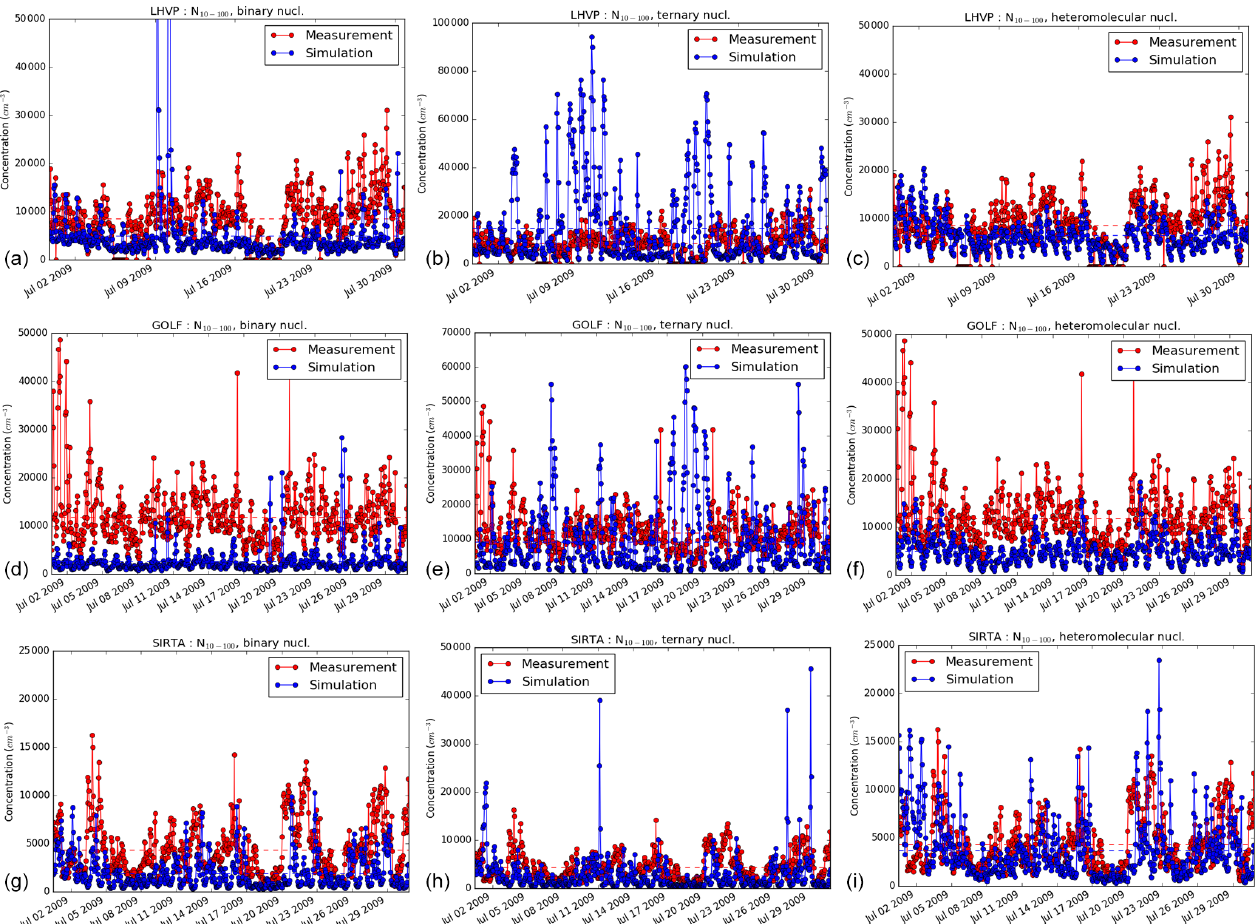
Figure 10. Hourly evolution of the number concentrations N 10 − 100 (in cm − 3 ) at the LHVP (a, b, c) , GOLF (d, e, f) , and SIRTA (g, h, i) sites for the simulation with binary nucleation (a, d, g) , ternary nucleation (b, e, h) , and heteromolecular nucleation (c, f, i) . Note that the maximum concentration is higher in the graphs with the ternary nucleation parameterisation than in those with the binary or heteromolecular nucleation